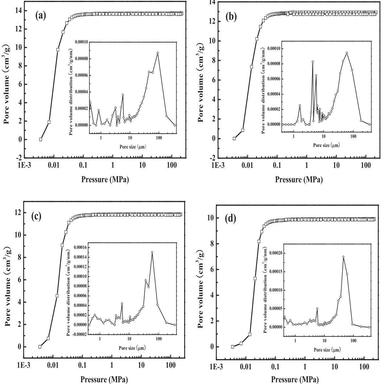
The curves of mercury injection and enjection, and pore diameter distribution curves of PFMs: (a) S1; (b) S2; (c) S3; (d) S4.